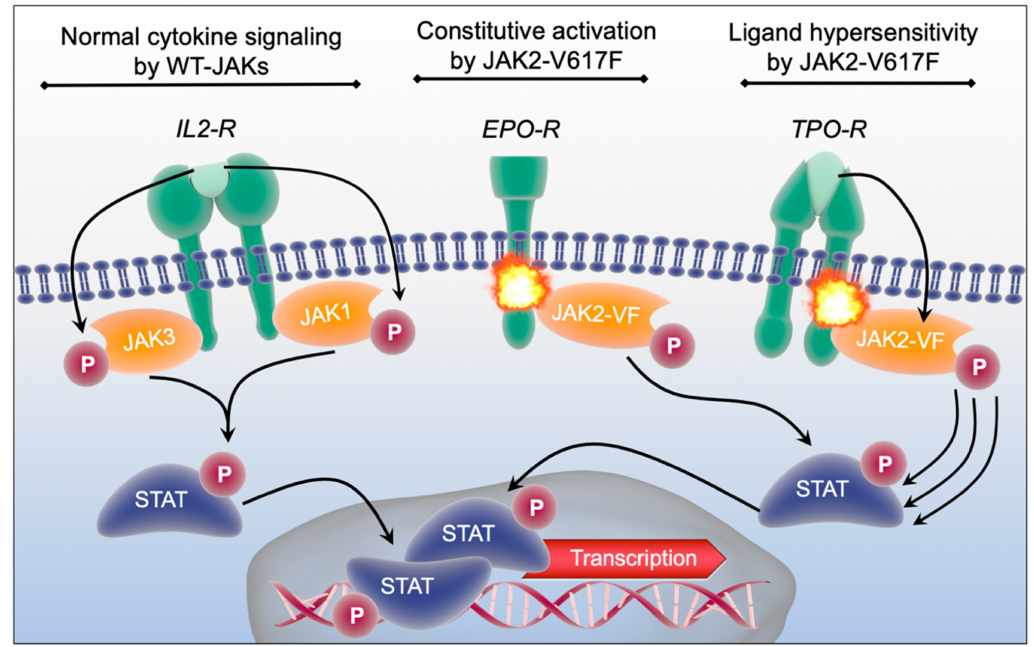
Figure 2. Schematic representation of normal and aberrant JAK-signal transduction. The IL2-receptor (IL2-R) associated with JAK1 and JAK3 serves in this cartoon as an example for physiological JAK-signaling dependent on cytokine binding. JAK2-V617F (JAK2-VF) is representatively depicted in association with the Erythropoetin-receptor (EPO-R) and the Thrombopoetin-receptor (TPO-R) where it induces constitutive activation and ligand hypersensitivity,